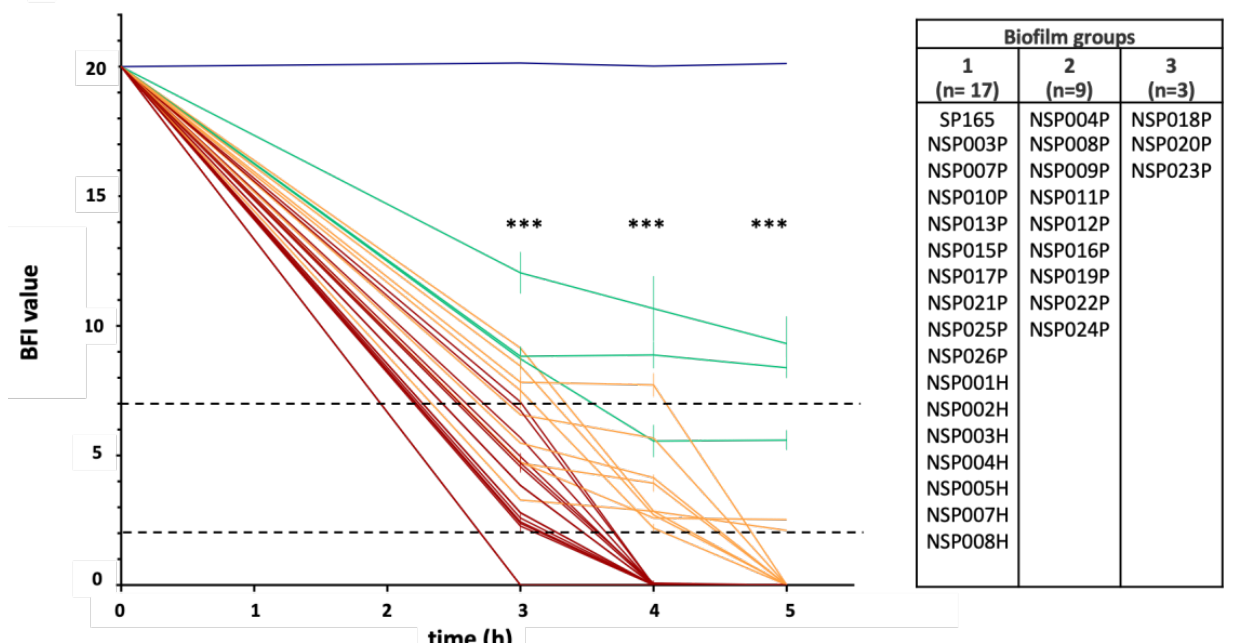
Figure 2. Ability of 29 S. pettenkoferi strains to form early biofilm in BHI using BRT ® (Biofilm Control) . K-means clustering led to three groups: in red, strains with early low biofilm index (BFI) values; in green, low adherent strains; in orange, strains with intermediate BFI values; and in blue, the S. pettenkoferi CIP 107711 reference strain with no biofilm production. Dotted horizontal lines: >7, no biofilm; <2, fixed biofilm. Means ± standard errors of the mean of BFIs for at least three independent replicates per group are presented. Statistical differences between BFI values of the three groups at 3, 4 and 5 h of incubation were obtained using Mann-Whitney tests. ***, p < 0.001.